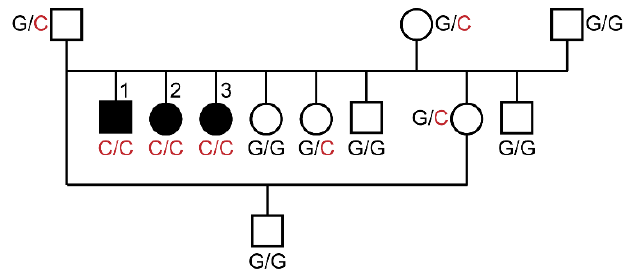
Figure 1. Pedigree of the investigated Turkish Van family. Squares represent males and circles females. The three affected kittens are numbered and indicated by filled symbols. Genotypes at the SCL39A4 :c.1057G>C variant are indicated.